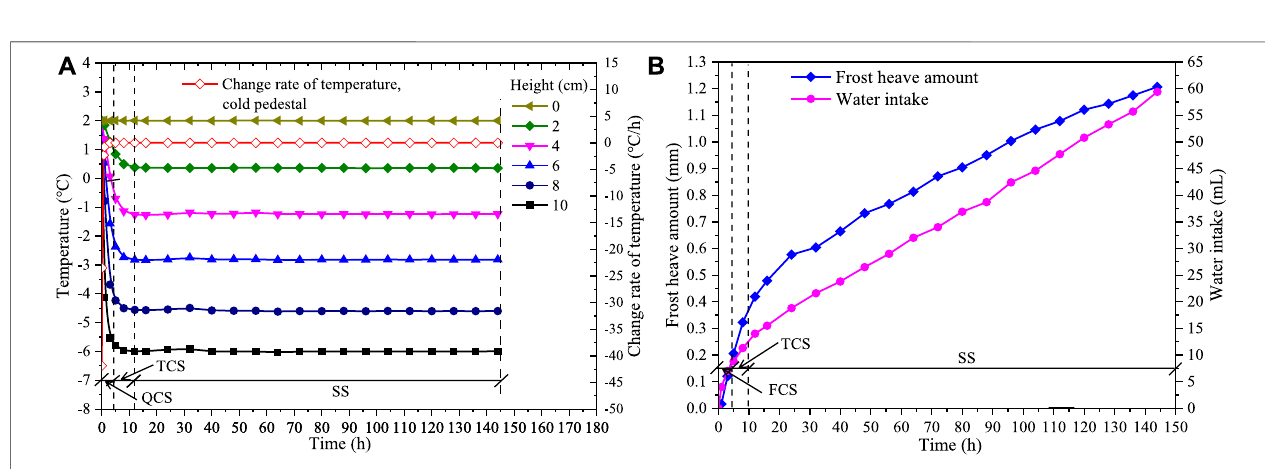
stages: the QCS, TCS, and SS ( Figure 9A ). The soil bottom other heights decreased as the soil top temperature decreased.